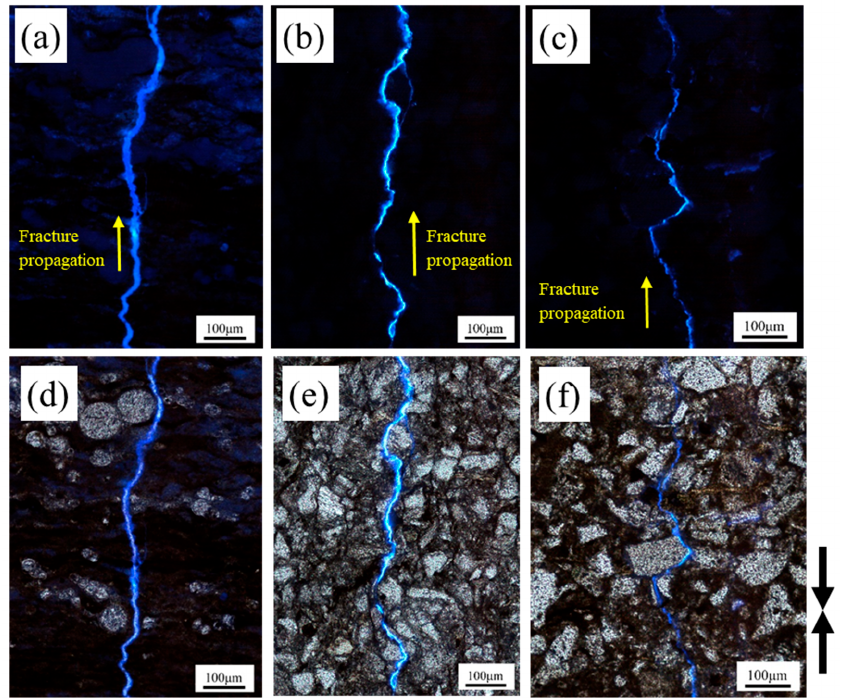
Figure 4. Patterns of hydraulically induced fractures observed in the thin sections prepared from the tested shale specimens in ( a , d ) Eagle Ford shale; ( b , e ) Inai shale; and ( c , f ) Kushiro shale. The images were obtained under ( a – c ) UV light and ( d – f ) a single nicol with UV light. The pair of black arrows next to ( f ) represents the loading direction. The induced fractures were tortuous and propagated in the shale matrix.